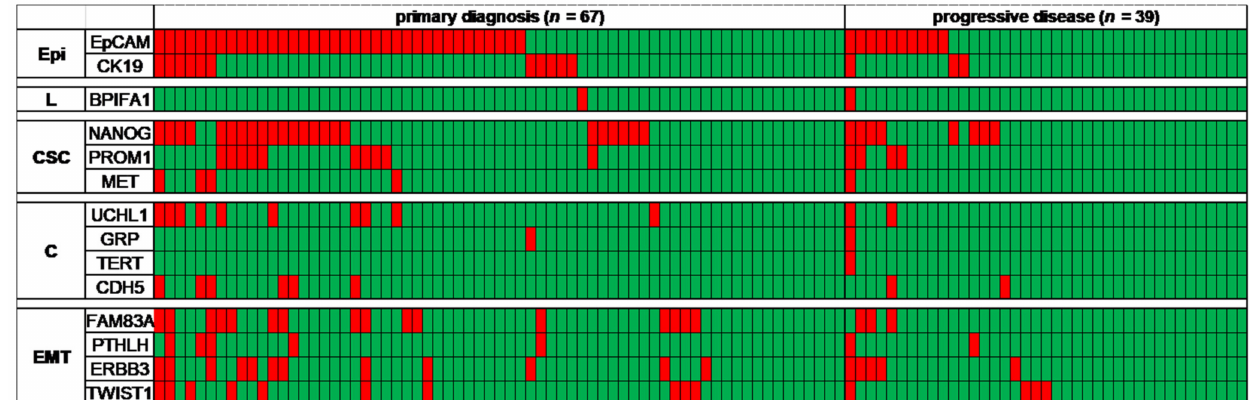
Figure 3. Heat map for transcript-specifics for epithelial cells (Epi), for ciliated epithelial cells in the lung (L), for the epithelial- to-mesenchymal transition (EMT), for cancer stem cells (CSC), and for other cancer-related transcripts (C). Red squares indicate gene expression beyond the calculated diagnostic threshold level per tested